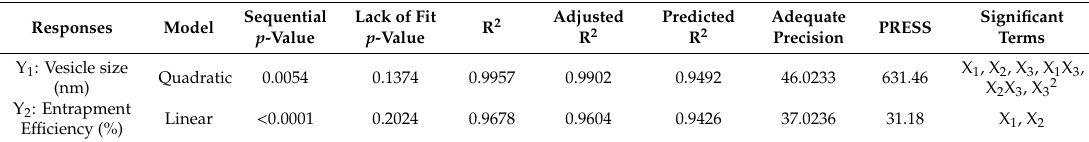
Table 3. Fit model statistics of SMV-EMLs responses prepared according to Box–Behnken design.